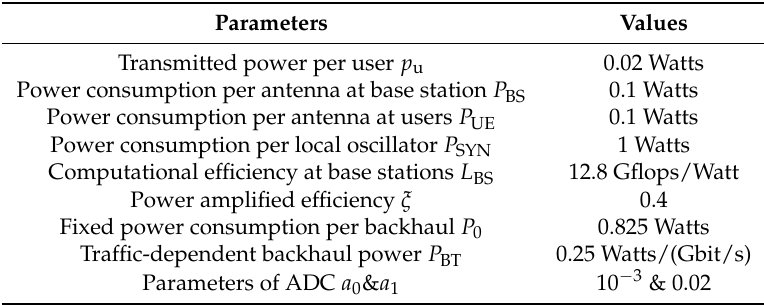
Table 1. Power consumption